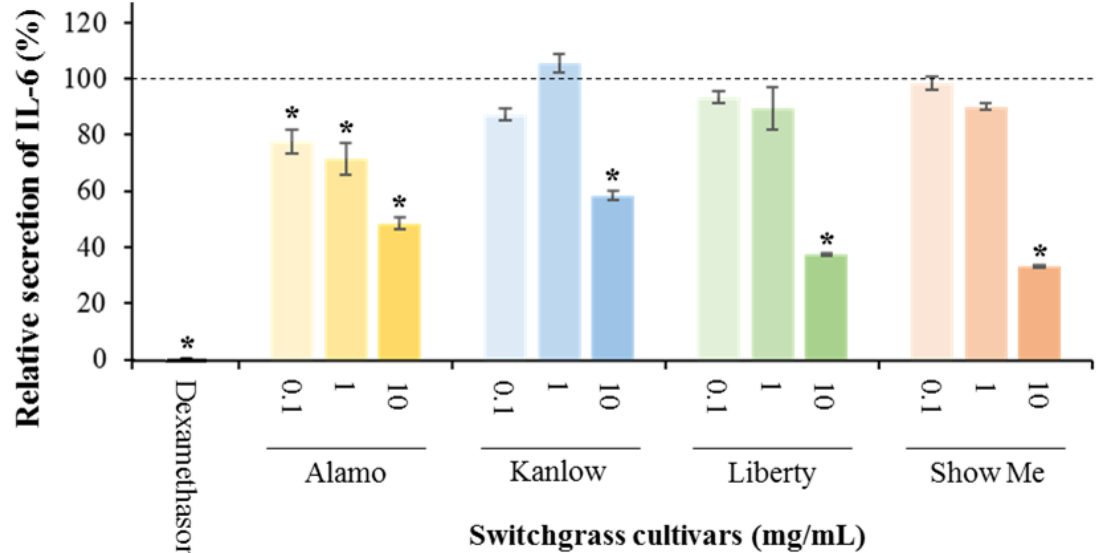
Figure 2. Effect of the switchgrass extracts on the expression of IL-6 in the U-937 model system. (*) Significant decrease ( p < 0.01) compared to the control cells without the extract. Mean ± SEM.